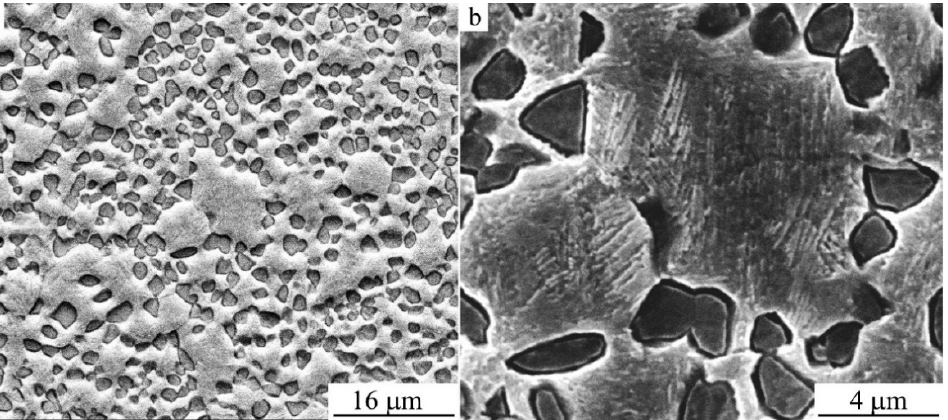
Figure 31. SEM images of the microstructure of the Cu-14Al-3Ni alloy after the HPT of 10 revs and annealing at 1073 K for 10 s, at ( a , b ) different magnifications [64].